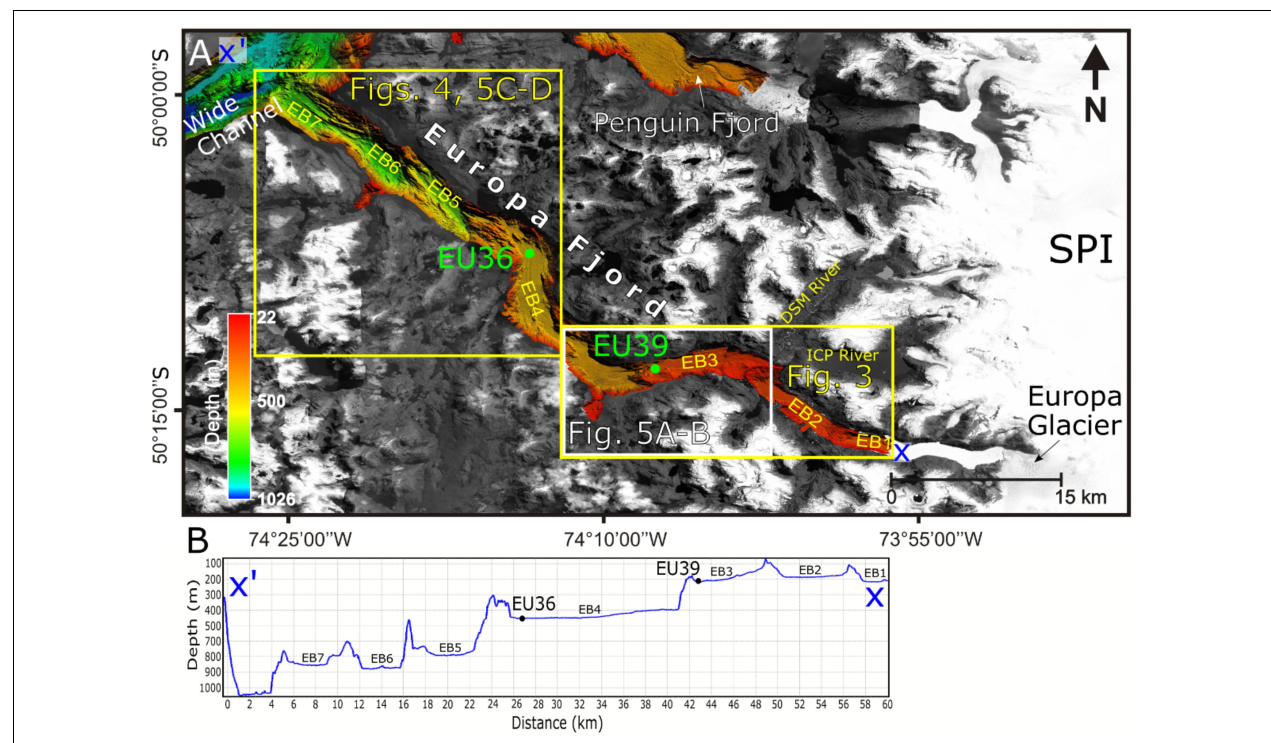
FIGURE 2 | (A) Shaded relief map that shows the coverage of the multibeam bathymetry from Cruise CIMAR 23 and SHOA data. Detailed submarine geomorphology and seafloor sediment distribution are showed in Figures 3–5 , respectively (boxes). (B) Longitudinal bathymetric profile of the Europa Fjord. Europa Basins (EB) are